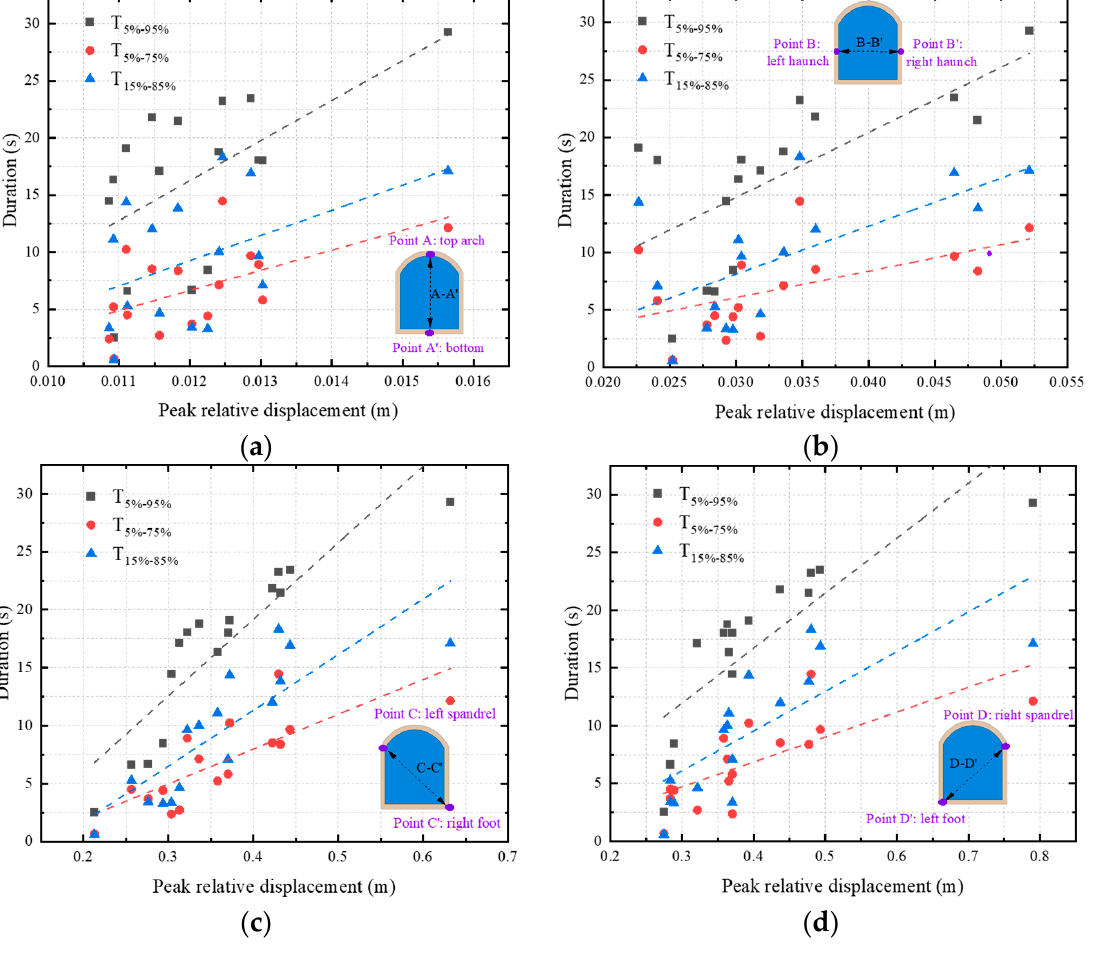
Figure 6. The relative peak displacement of the concrete lining under different fixed threshold values of EVD (( a ) the right spandrel—left foot, ( b ) the left spandrel—right foot, ( c ) the top arch—bottom, ( d ) the left haunch—right haunch).